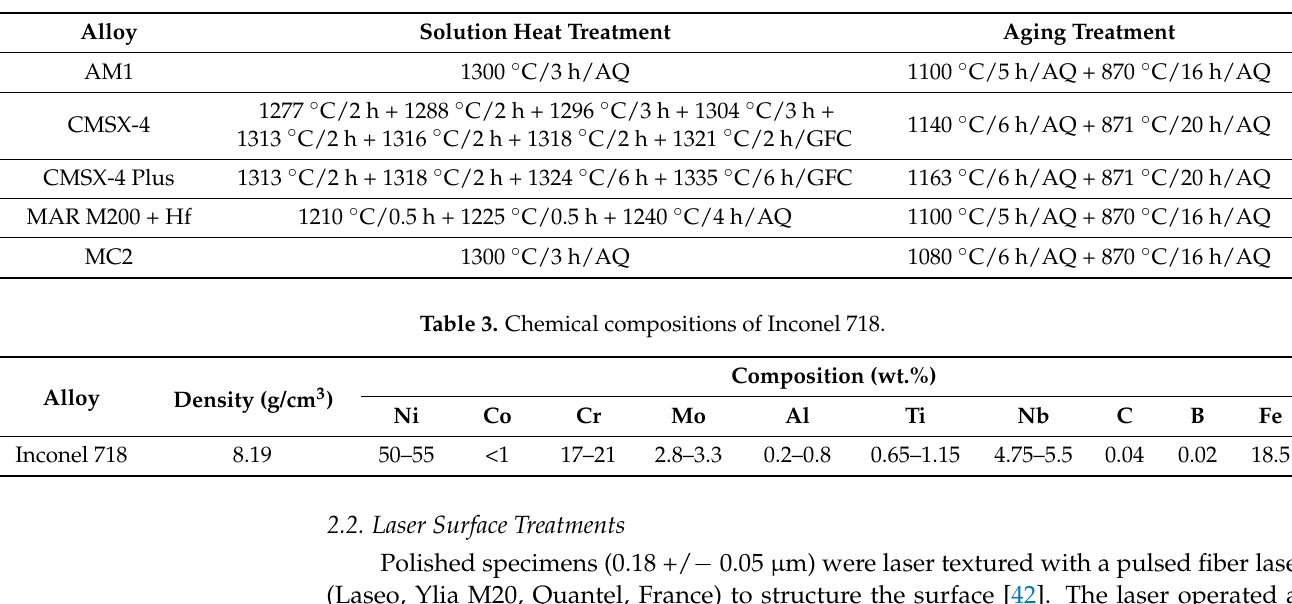
Table 3. Chemical compositions of Inconel 718.